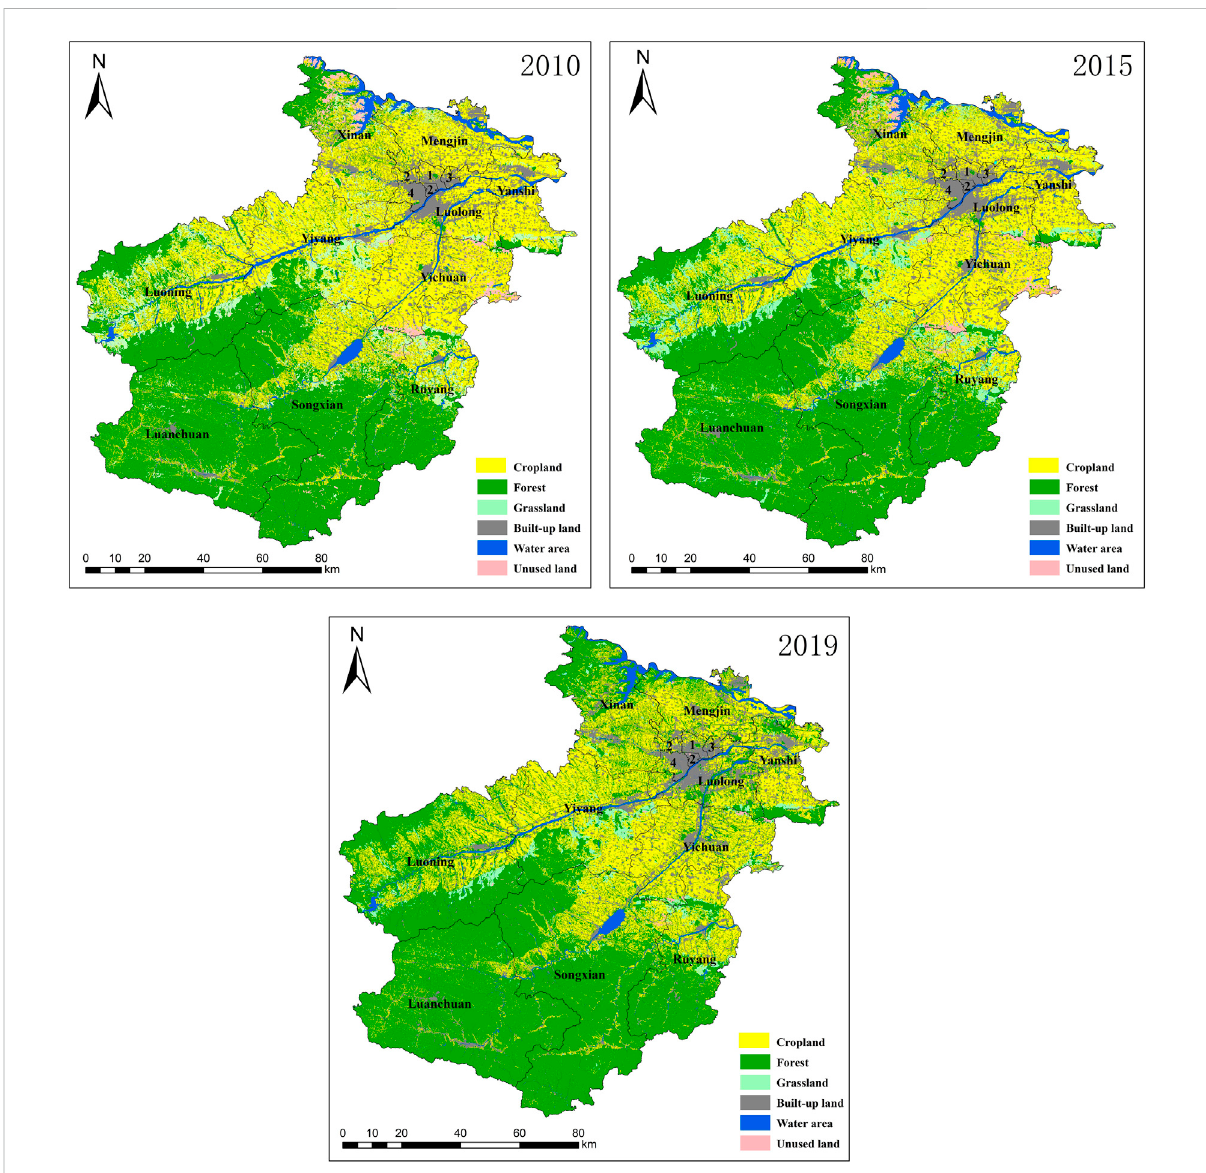
FIGURE 3 Spatial distribution of LUCC in Luoyang in 2010, 2015, and 2019. Key: 1. Laocheng District, 2. Xigong District, 3. Chanhe District, and 4. Jianxi